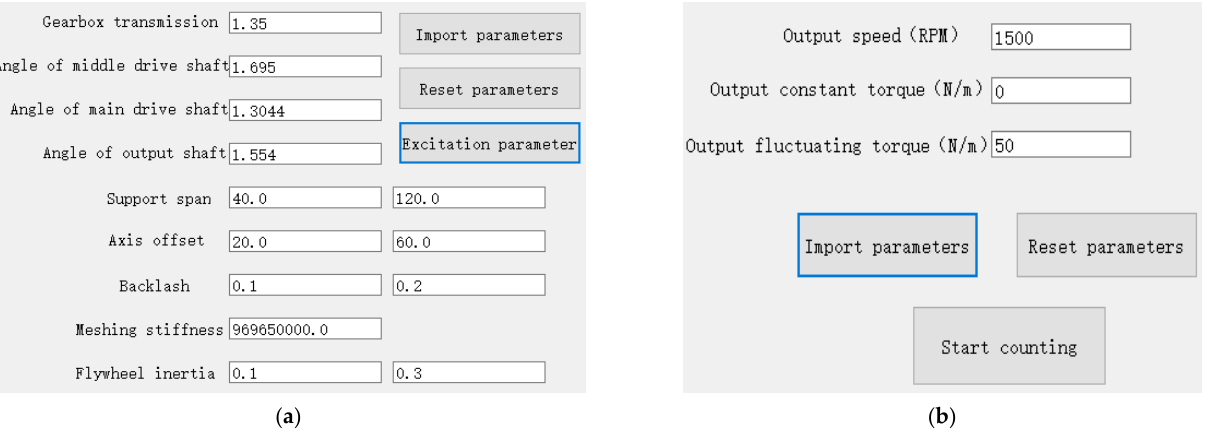
Figure 11. Results of design: ( a ) optimization parameters interface; ( b ) excitation parameters interface.